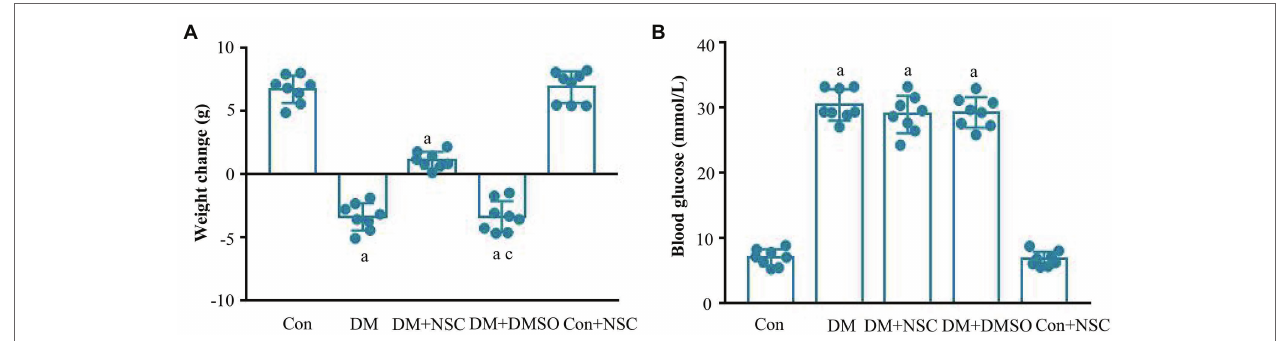
FIGURE 2 | Biochemical indexes. (A) Evaluation of body weight in each group. (B) Detection of blood glucose level in each group. Data are shown as mean ± SD. a p < 0.05 vs. Con group; b p < 0.05 vs. DM group; c p < 0.05 vs. DM + NSC group; Con, normal control group; DM, diabetes group; DM + NSC, inhibitor group;